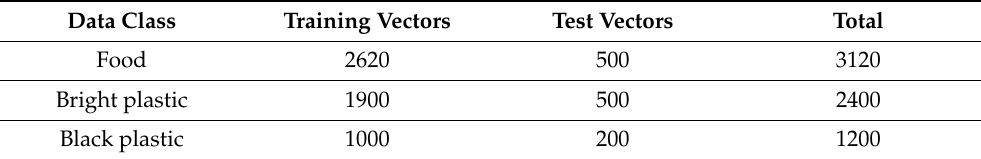
Table 4. Number of vectors per data class for HDR and non-HDR datasets (case